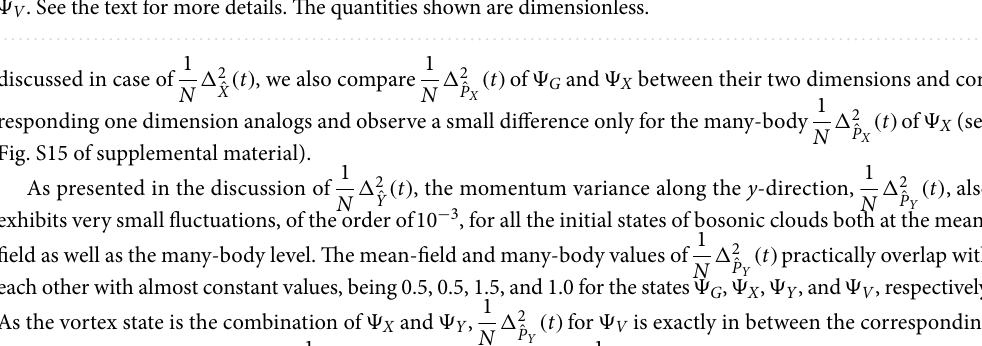
1 time-adaptive orbitals, in red) and many-body (in blue) time-dependent = 1 1 � 2 ( t ) and � 2 ( t ) , are presented in the left and right columns, respectively. N N ˆ X ˆ Y 10 bosons are plotted row-wise. The many-body results = 6 orbitals for (cid:31) 10 orbitals for (cid:31) G and (cid:31) X and M = Y and =